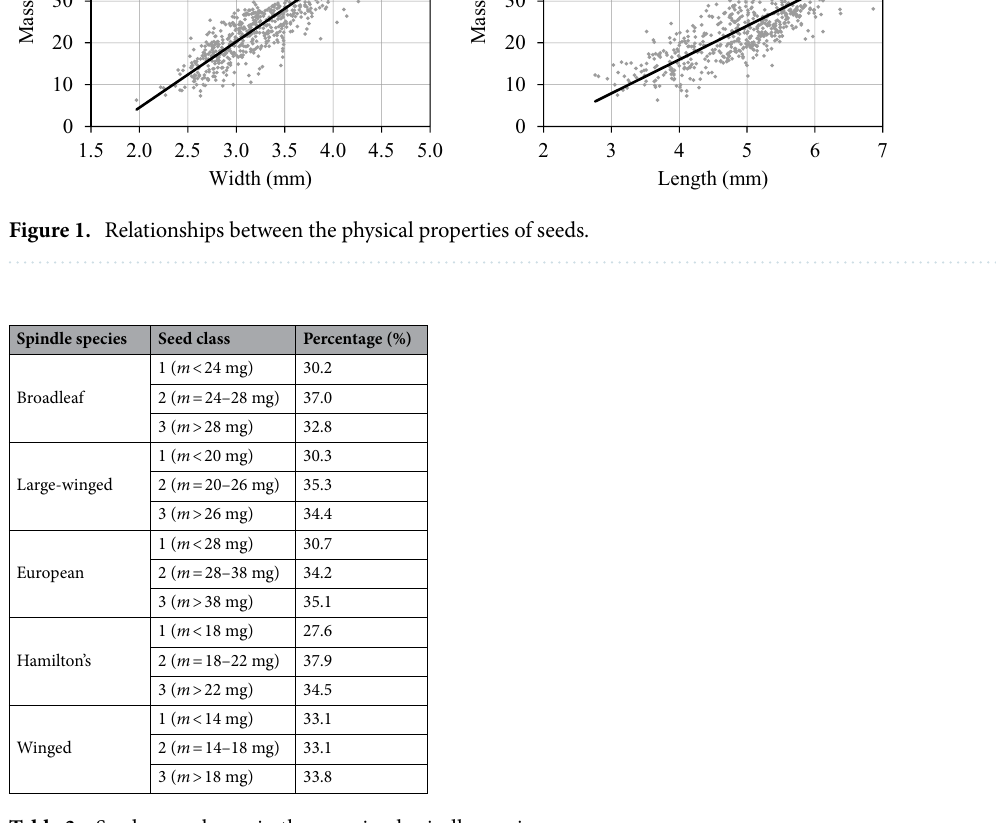
Table 3. Seed mass classes in the examined spindle species. m